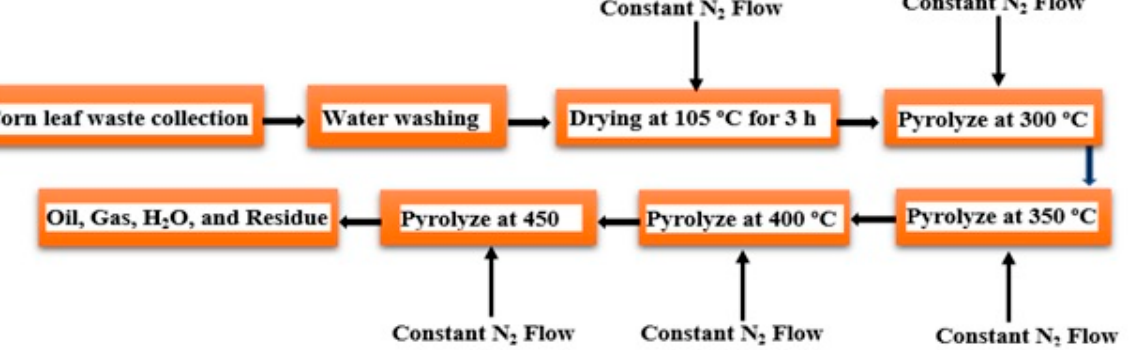
Figure 9. Scheme describing the synthesis of biofuel from corn leaf waste.